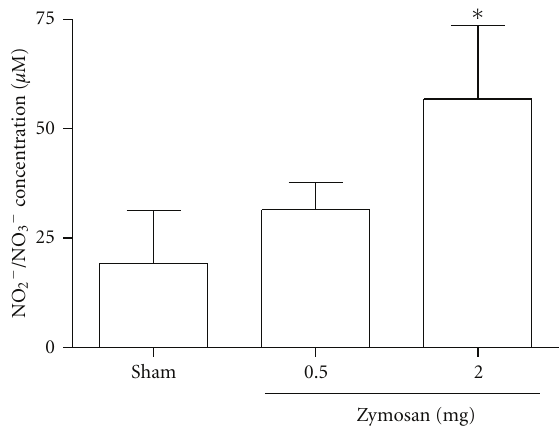
Figure 6: Nitrite levels in synovial exudates of zymosan-induced TMJ arthritis. Zymosan was injected i.art. and the NO release in exudates (as NO 2 − /NO 3 − ) was measured 6 h after zymosan. Sham animals received only saline i.art. Injection of saline into the joints did not increase NO release throughout the experiment. Data are expressed as means ± SEM ( n = 6). ∗ P < . 05 versus Sham (ANOVA,